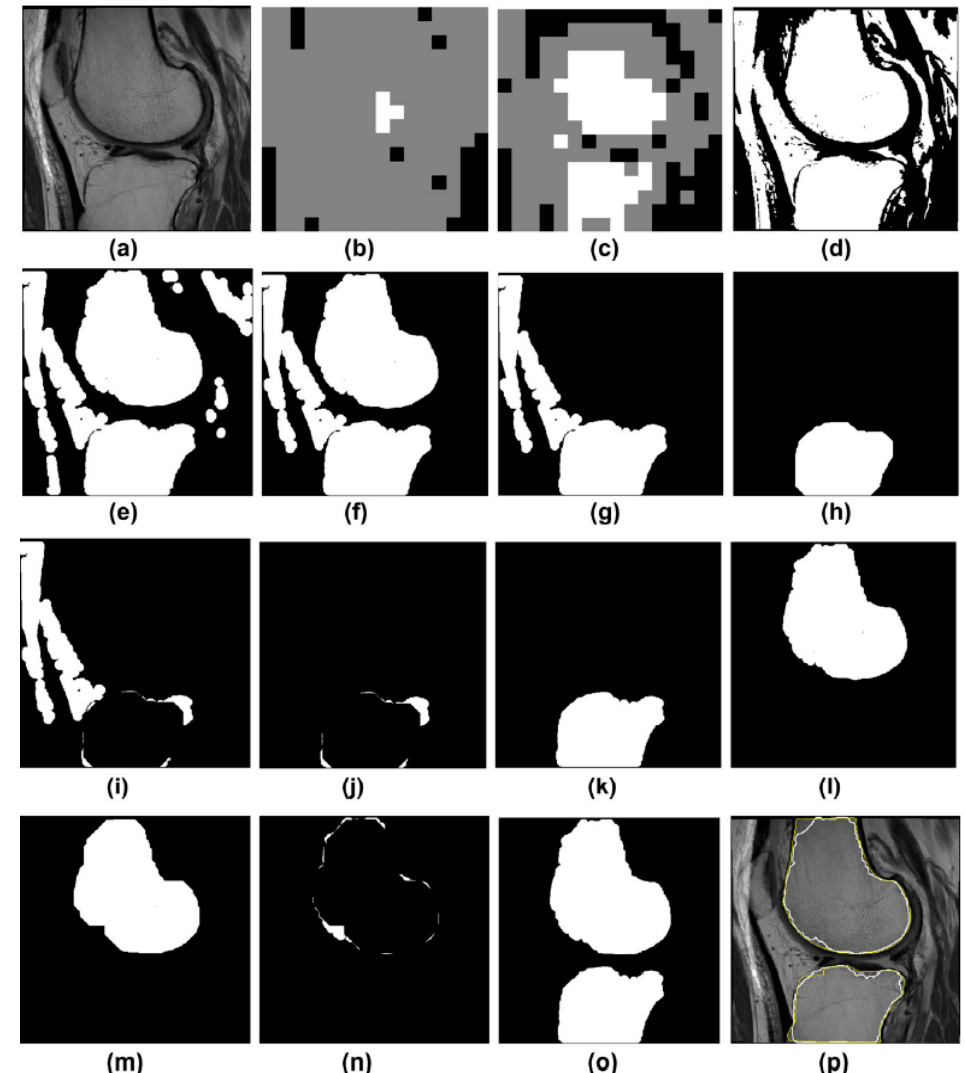
Figure 4. An example illustrates both ROI detection failures/recoveries and leak detection and correction. ( a ) An MRI image; ( b ) the ROI block is detected with only the femur bone detected, not the tibia; ( c ) after lowering the ROI detection threshold, both bones are detected; ( d ) mask for the GC output; ( e ) after morphological processes; ( f ) the resulting two potential skeletons, with a leak seen in the tibia bone; ( g ) the tibia bone has a leak that connects fat and other tissues to the tibia; ( h ) initial step in detecting a leak is to use a morphological opening; ( i ) residual content resulting from subtracting ( h ) from ( g ). ( j ) Following an examination of the remains in ( i ), the leak detection method identifies a leak and decides that only the pixels in the leak are affected; ( j ) are relevant to the tibia ( k ) after adding the appropriate pixels in ( j ) to ( h ), resulting in a leak-free tibia ( i ), the femoral mask ( l ) and ( m ). After applying the morphological aperture to check for leakage ( n ) the remaining pixels after subtracting ( m ) from ( i ). On this basis, it is concluded that there is no leak, and the pixels are reinserted ( o ). ( o ) femur and tibia masks as a result ( p ) GC segmentation in white and manual segmentation in yellow determined with DICE = 0.95 and 0.96 resolution for femur and tibia bones, respectively